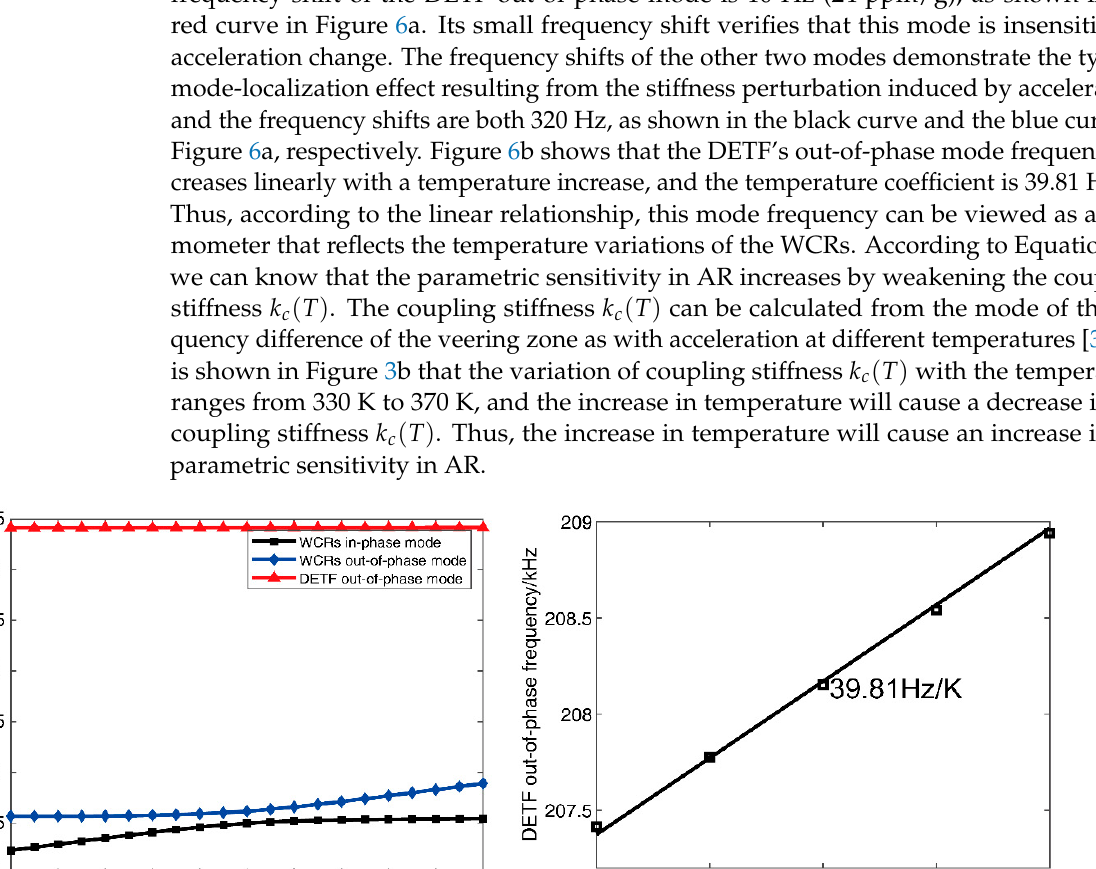
Figure 7. The flow charts implement the DETF-CC WCRs accelerometer temperature compensation method. In the first step, the DETF-CC WCR accelerometer is subjected to temperature and acceleration, rhe WCRs in-phase mode and WCRs out-of-phase mode output amplitude ratio, and the DETF out-of-phase mode outputs frequency. Then, the amplitude ratio of